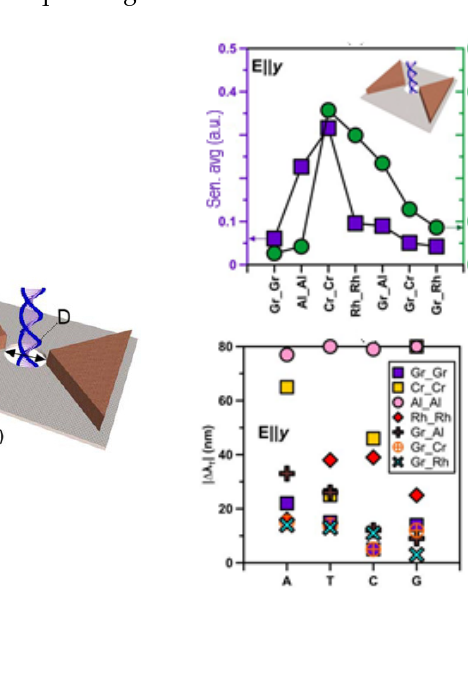
Figure 5. ( a ) Schematic illustration of the proposed structures and the DNA molecule present. ( a ) Nanosheet with a pore (nanopore structure); ( b ) Bowtie structure. ( c ) Bowtie-nanopore compound structure. ( d ) Bowtie-nanopore combination, a = 3 nm, D = 2 nm, g = 1.5 nm and the bowtie side length was 2 nm. Graph (upper left) shows minimum selectivity and average sensitivity. Graph (down left) shows total peak wavelength shifts relative to the condition where no nucleotide was present. Graph (Upper right) shows SPR spectra with no nucleotide. Graph (down left) shows SPR spectra in the presence of nucleotide A. Adapted with permission from Fotouhi et al. [36] Copyright © 2016 Optical Society of America.